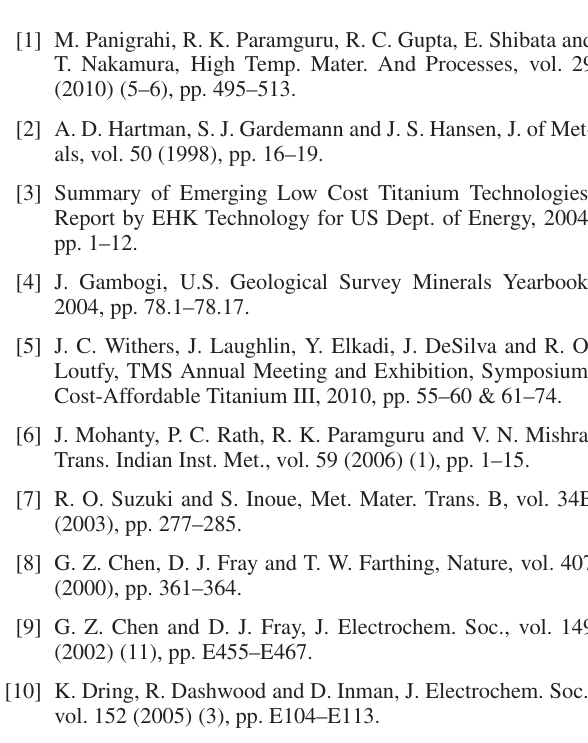
pellet for different time 2